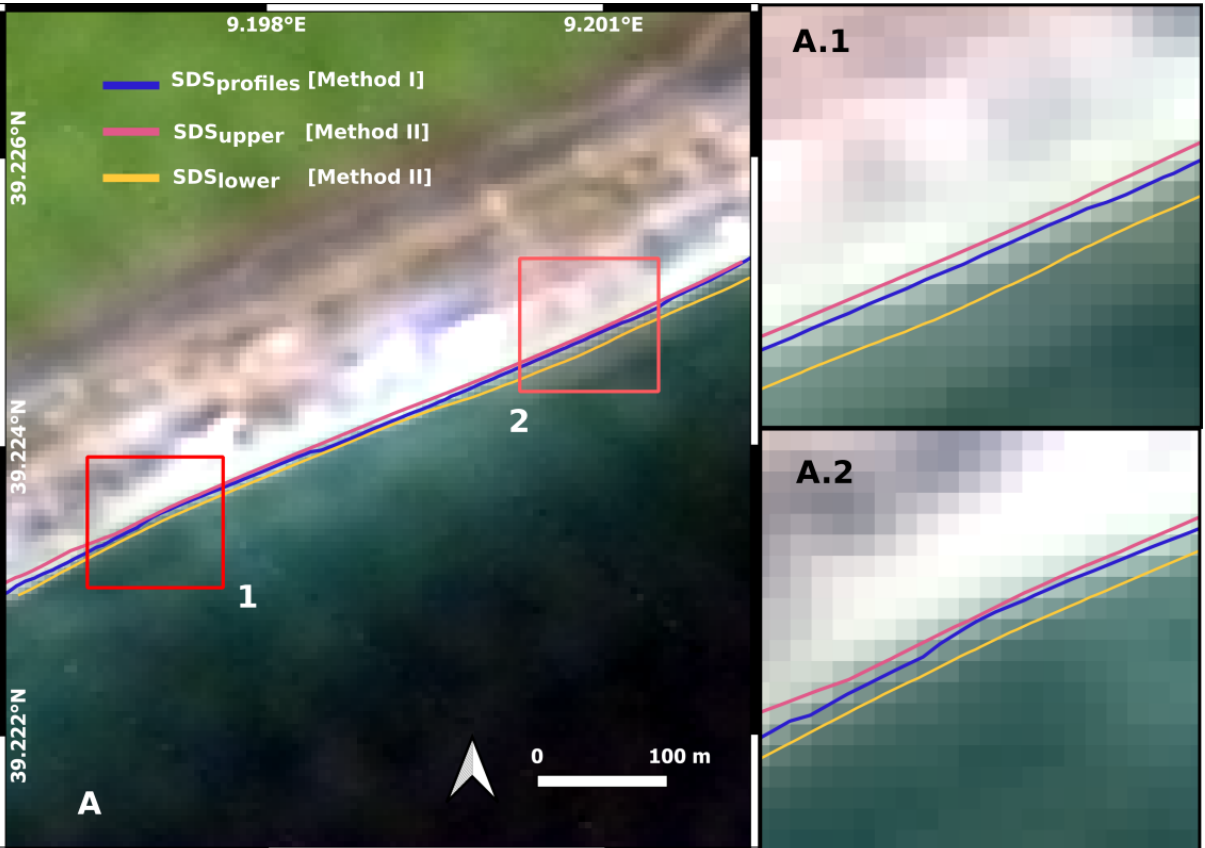
Figure 11. Example of the SDSs retrieved with the two methods in the Poetto04 AoI ( A ). The red squares identified with numbers are the zooms shown on the right side of the figure ( A.1 , A.2